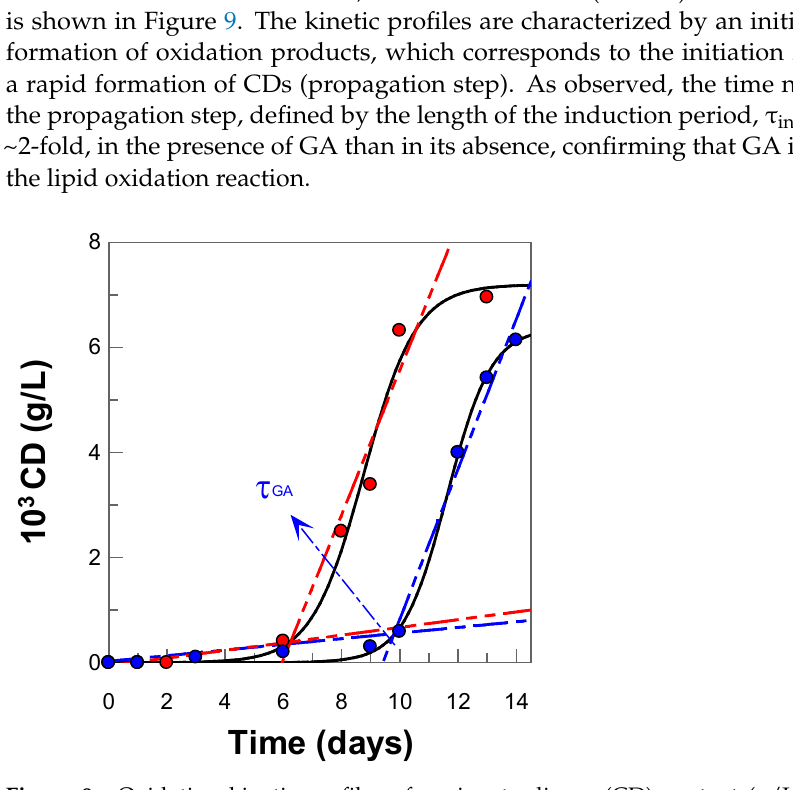
Figure 9. Oxidation kinetic profiles of conjugate dienes (CD) content (g/L) in 1:9 ( v:v ) olive-oil-in- water nanoemulsions, T = 60 °C in absence ( • control) and presence of gallic acid-( • GA) ([GA T ] = 10 − 4 M).